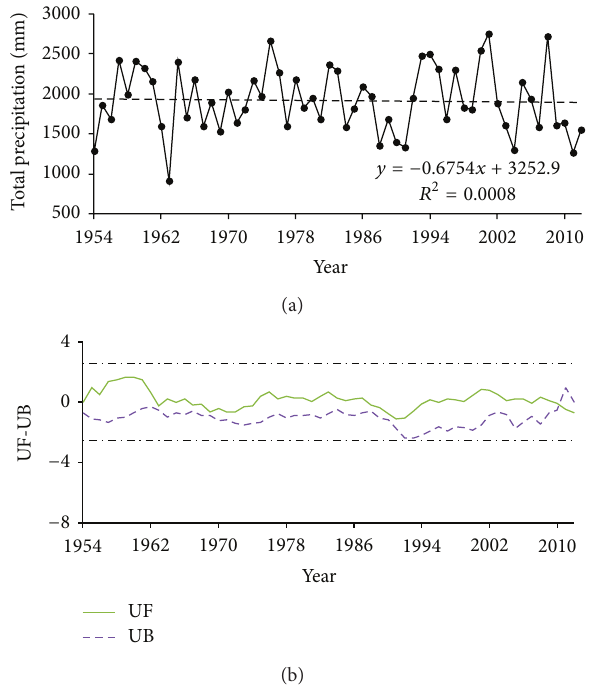
Figure 5: Temporal trend of the mean relative humidity (a) and the trend results from the Mann-Kendall method